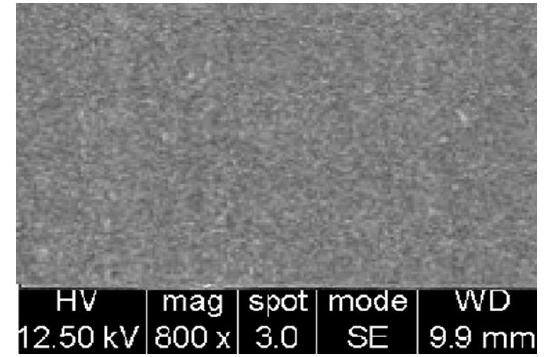
Figure 11. Surface of the material before EDM.